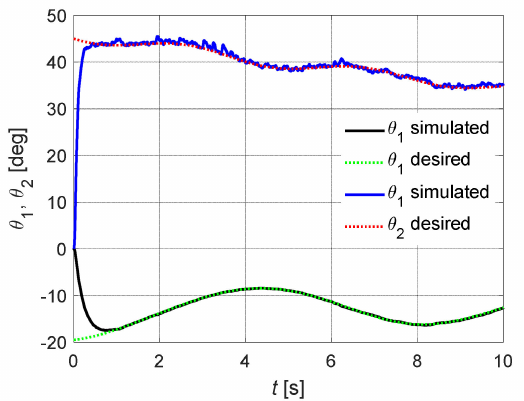
Figure 13. Angular displacements simulated and desired in azimuth and elevation with random interference—LQR